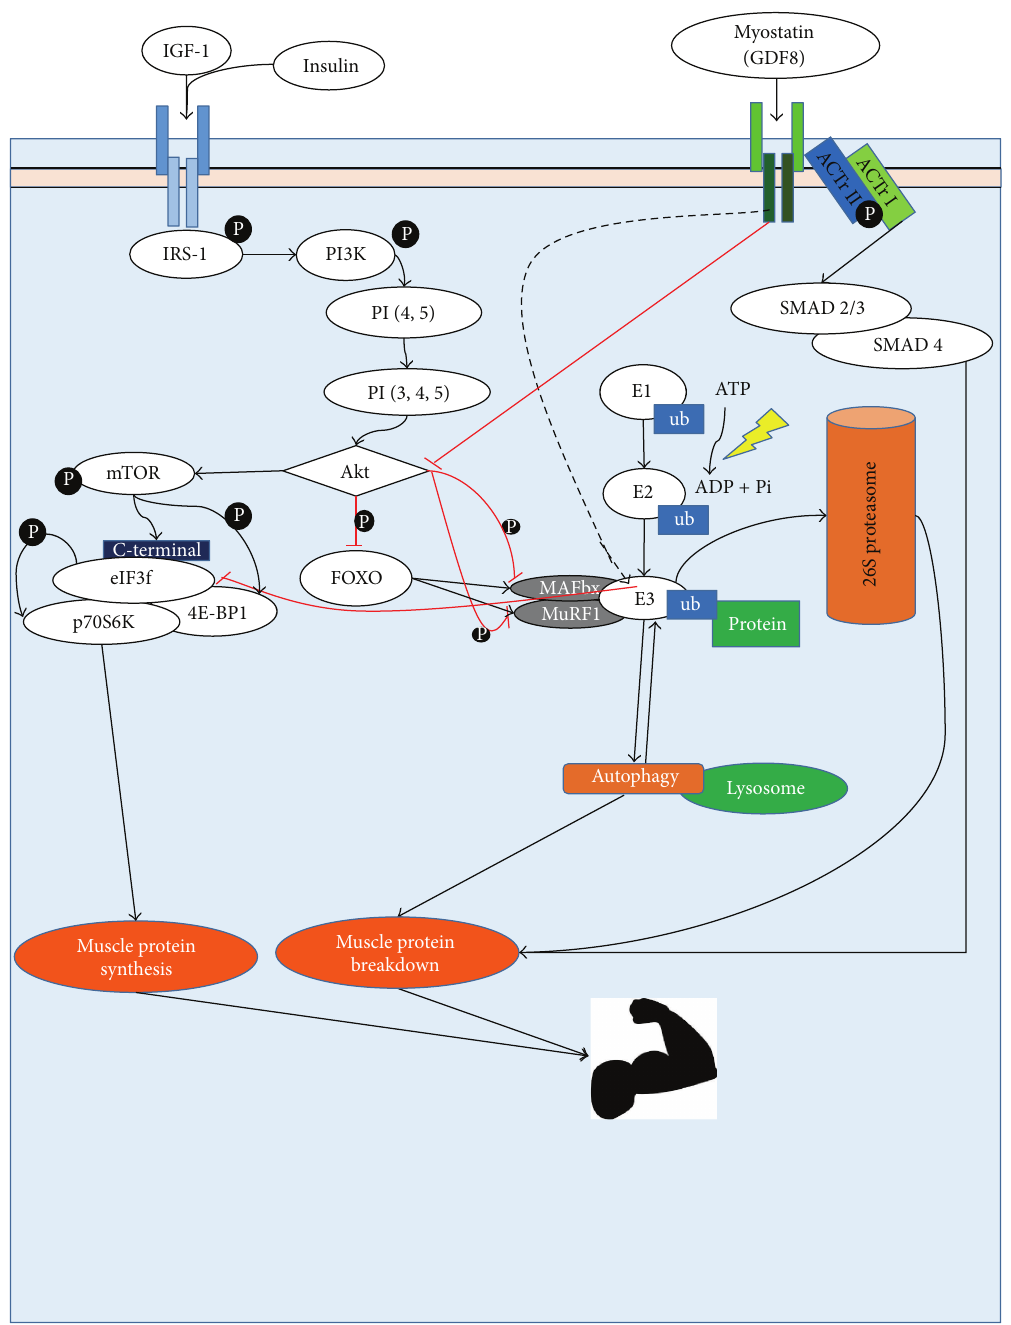
Figure 1: Anabolic and catabolic pathways regulating muscle mass. P = phosphorylation; Ub =